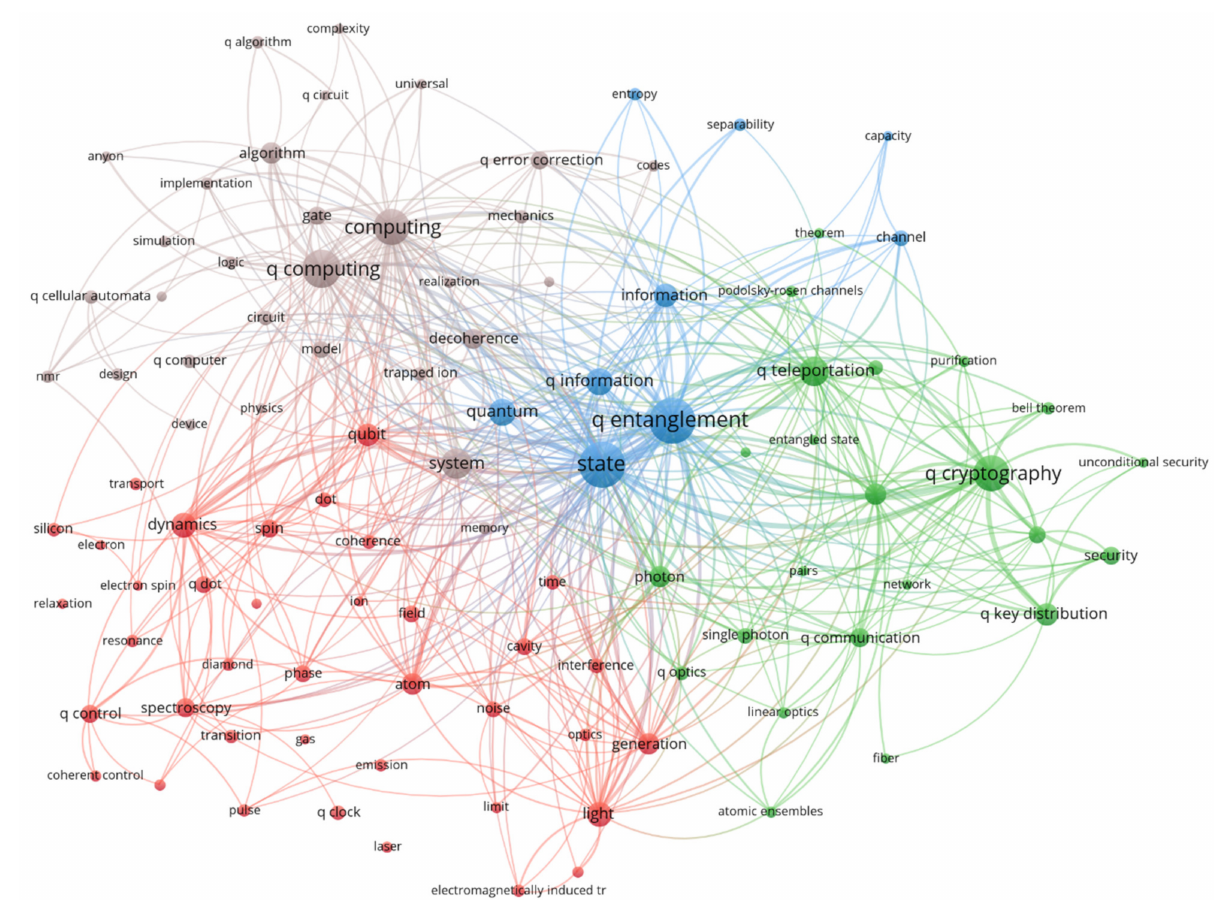
Figure 5. Co-occurrence map of the top 100 keywords (author keywords and keywords plus from 1980 to 2018) with four topical clusters, using the VOSviewer parameters resolution = 1.0 and minimal cluster size = 5. (The two biggest unnamed green nodes belong to the keywords communication and key distribution, respectively.) For better readability, in compound keywords quantum is abbreviated to q. Readers interested in an in-depth analysis of our publication set can use VOSviewer interactively and zoom in on the clusters. An online version is provided at https://s.gwdg.de/1Bg9EB (accessed on 1 August 2021) (cluster colors probably